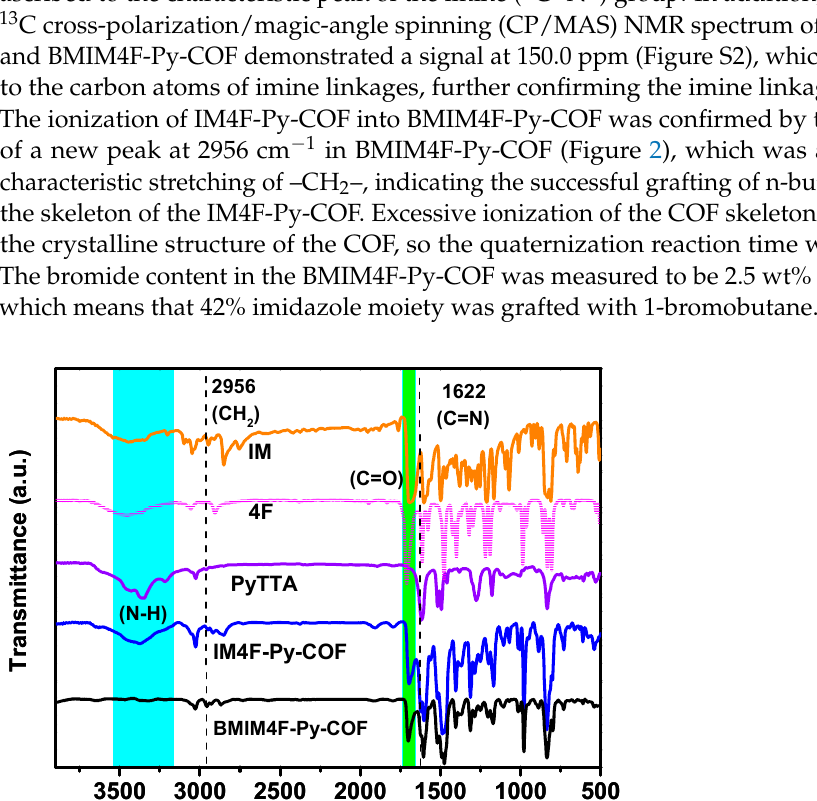
Figure 1. PXRD patterns of IM4F-Py-COF. Experimental pattern (black), profiles simulated using the Pawley refinement (red), the difference between experimental and refined patterns (magenta), AA-stacking (blue) and AB-stacking (green) modes of the IM4F-Py-COF.